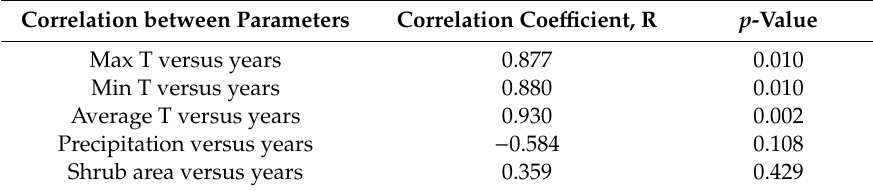
Table 1. Results of correlation analyses.